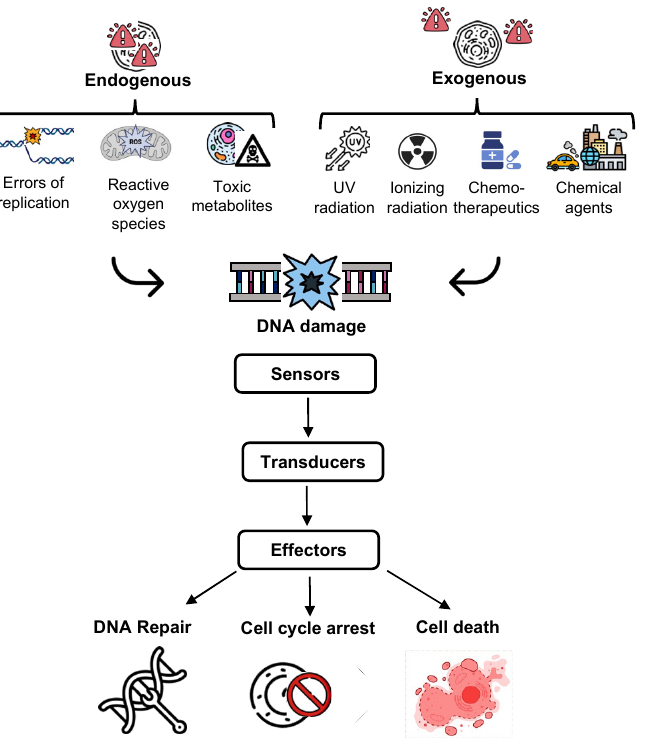
Figure 1. Simplified representation of the DNA damage response (DDR) activated by endogenous or exogenous DNA-damaging agents. This figure has been created using images from BioRender.com and Flaticon.com.